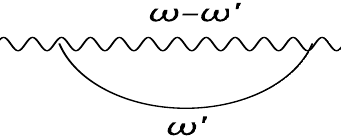
Figure 27 . Example of a vanishing diagram. The wavy line denotes the reggeized gluon, the straight line the elementary